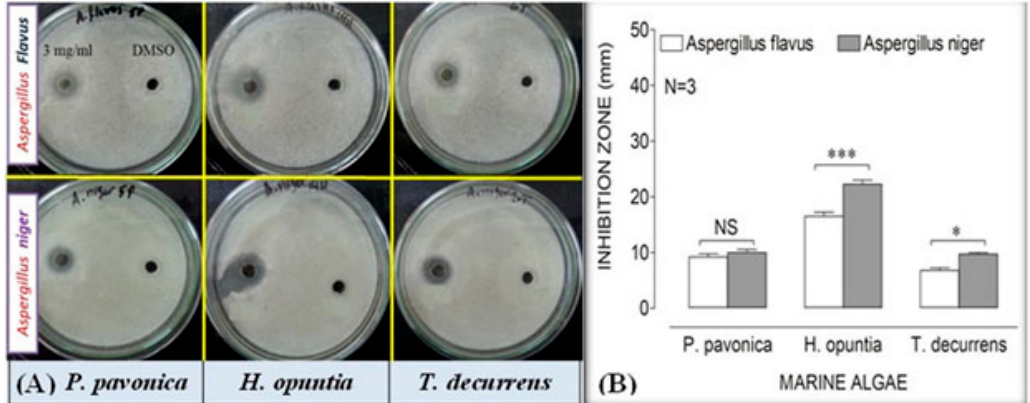
Fig. 3. Antifungal screening of algal extracts (3 mg/ml); Padina pavonica, Halimeda opuntia and Turbinaria decurrens , and dimethyl sulfoxide (DMSO), as negative control, against Aspergillus flavus and Aspergillus niger . The activity was determined by zone of inhibition using Sabouraud agar well diffusion method. Only +ve values of the examined algal extracts were recorded (Fig. 3A). DMSO showed no inhibition. Effect of each algal extract on Aspergillus species was shown in Fig. 3B. All data were set as mean ± SEM of three replicates (n = 3). The difference between groups were considered significant at *P<0.05 and